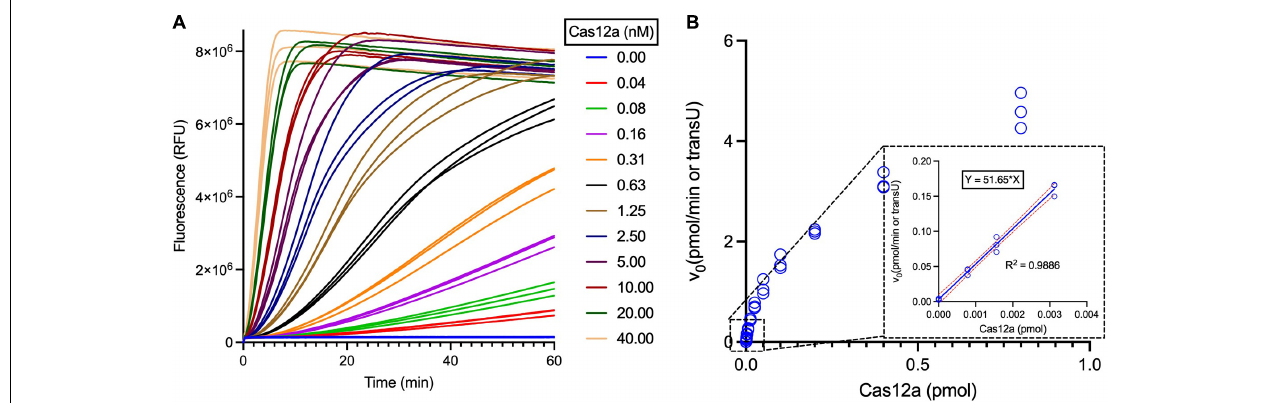
FIGURE 5 | Measurement of the LbCas12a specific trans -cleavage activities. (A) Fluorescent curves of the Cas12a trans -cleavage reactions with different concentrations of LbCas12a. LbCas12a was twofold serially diluted for the trans U measurement, using 1 µ M ssDNA reporter as the substrate and following the Supplementary Protocol . (B) Curve plotting of calculated initial reaction rate versus the LbCas12a concentrations. The linear region of the reactions was boxed and enlarged, and the data were further employed for trans U